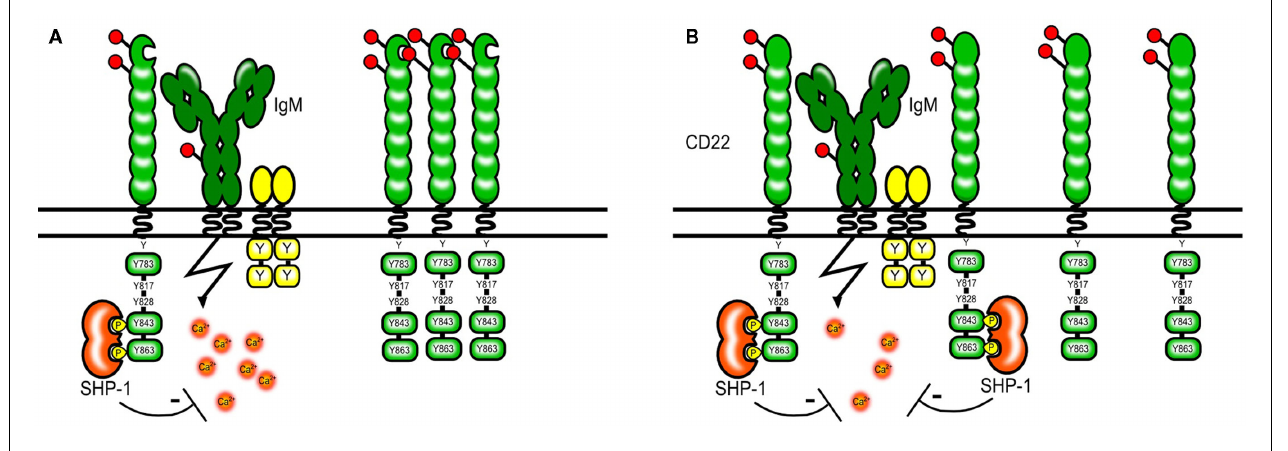
expressing CD22 that cannot bind sialic acids.This makes CD22 more available to interactions with the BCR and subsequently leads to a stronger inhibition of the BCR signal [shown in (B) ]. A similar situation might arise in ST6Gal-deficient mice lacking CD22 ligands.